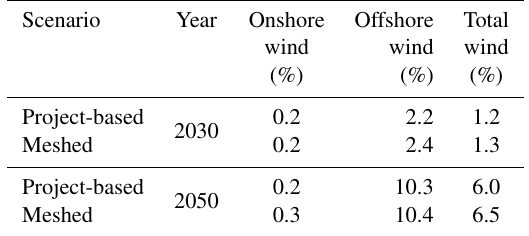
Table 3. VRE curtailments for the project-based and meshed off- shore grid scenarios. Shares with respect to available production.